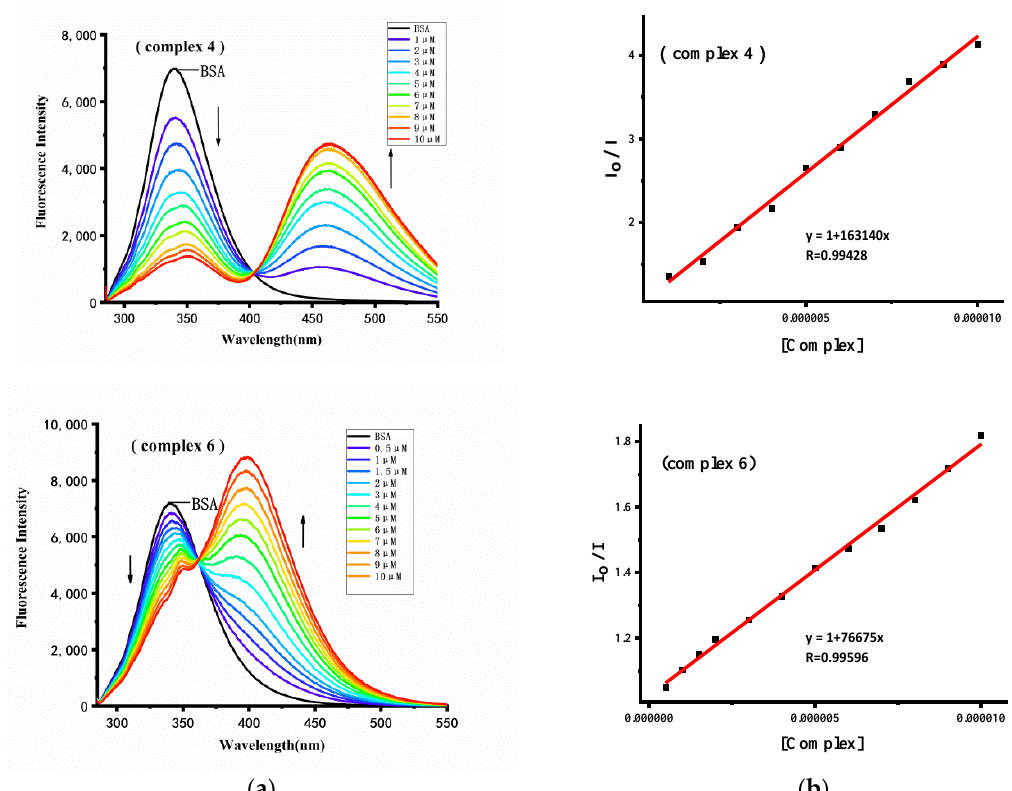
Figure 6. ( a ) Fluorescence emission spectra of 1.6 μM BSA in a Tris-HCl buffer (pH = 7.2) solution with series concentration of compounds 4 and 6 , and ( b ) curves for the Stern–Volmer equation as the insets.